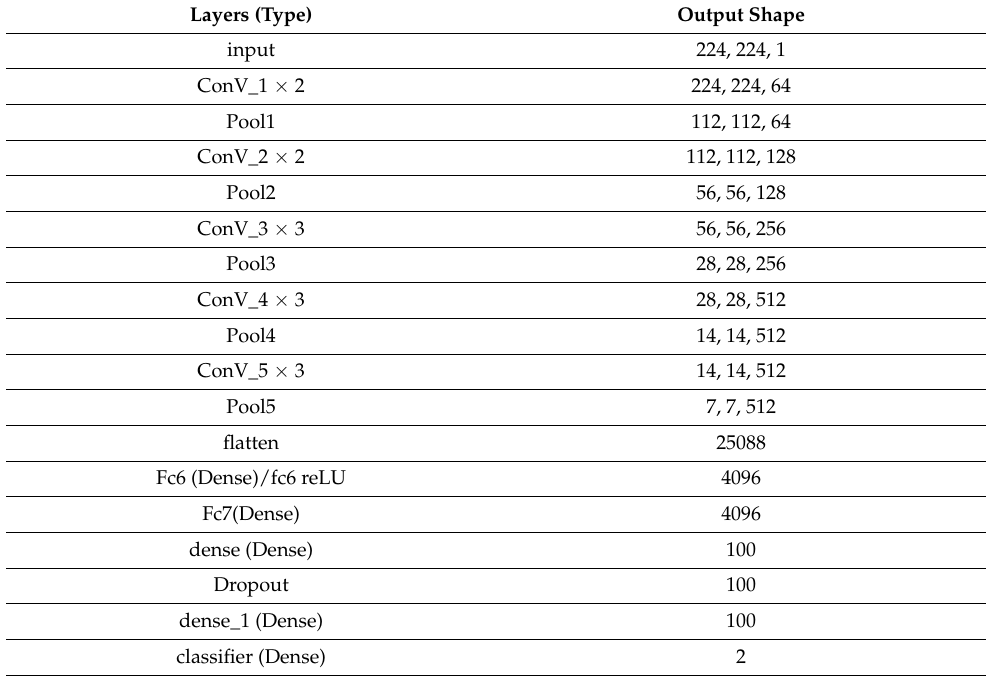
Table A1. CNN based Deep Learning model architecture described in Section 2.2.1 and result reported in Section